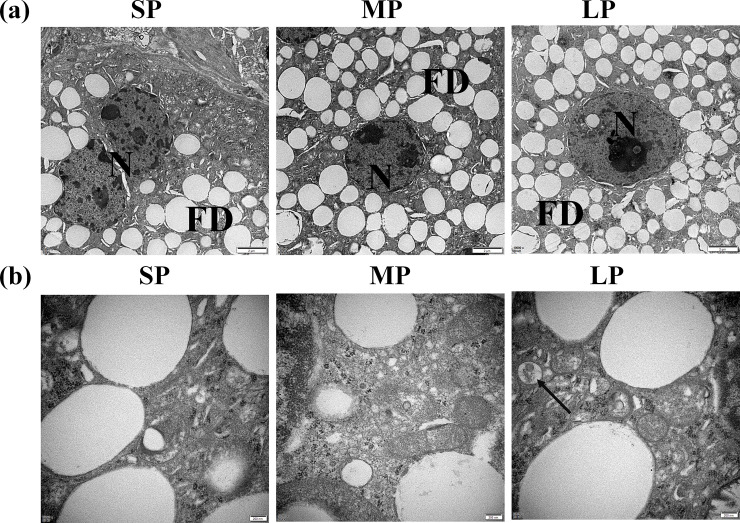
Ultrastructure of HG in hamsters from three photoperiodic groups.(a) Nucleus ultrastructure of HG in hamsters from three photoperiodic groups. There were no significant differents in nuclear (N) morphology among three photoperiodic groups. Large number of fat droplets (FD) were observed in secretory cells of HG. Scale bar = 2 μm. (b) Autophagolysosomes of HG in hamsters from three photoperiodic groups. Significant autophagolysosomal structures (see arrow) were observed in LP group. In other groups, autophagolysosomal structures were hardly observed. Scale bar = 0.2 μm. SP, short photoperiod; MP, moderate photoperiod; LP, long photoperiod.